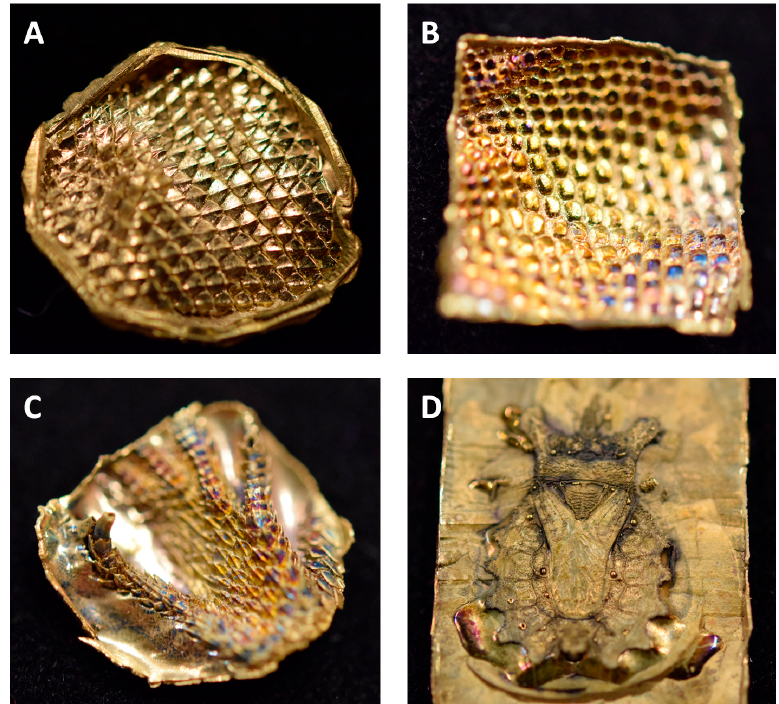
Figure 3. Representative examples of the all-metal replicas of biological surfaces. ( A ) Ventral and ( B ) lateral scales of P. cornutum . ( C ) Foot of P. cornutum . ( D ) Whole dorsal body surface of D. lunatus . Replicas shown in ( A – C ) are approximately 1 cm 2 , and replica shown in ( D ) is approximately 1 × 2 cm.